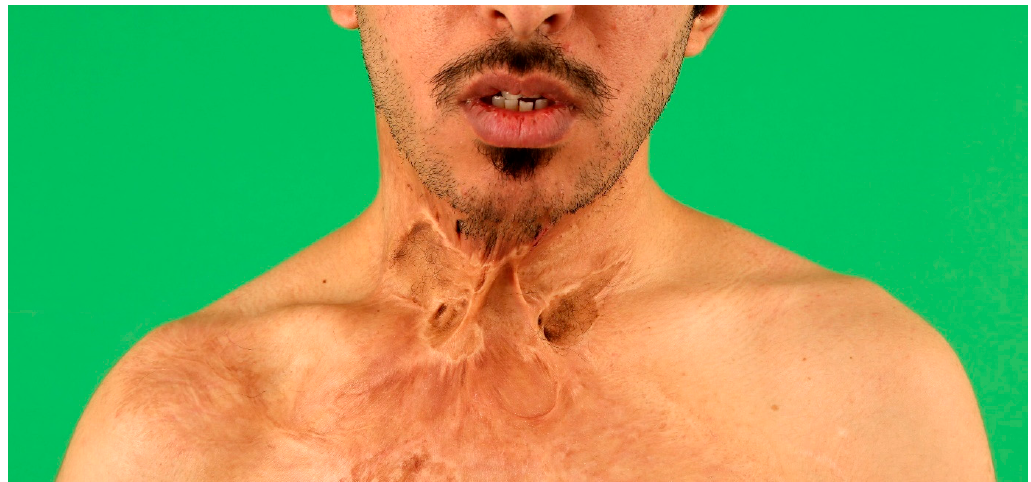
Figure 4. Ventral neck contracture one year following burns resulting from a domestic fire. Reclination of the neck is severely impaired and the patient suffers from pain due to the contracting scar.